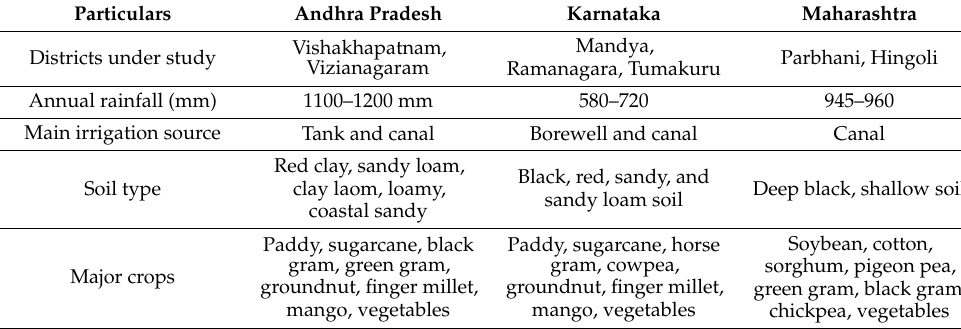
Table 2. Geographical characteristics of the study area.